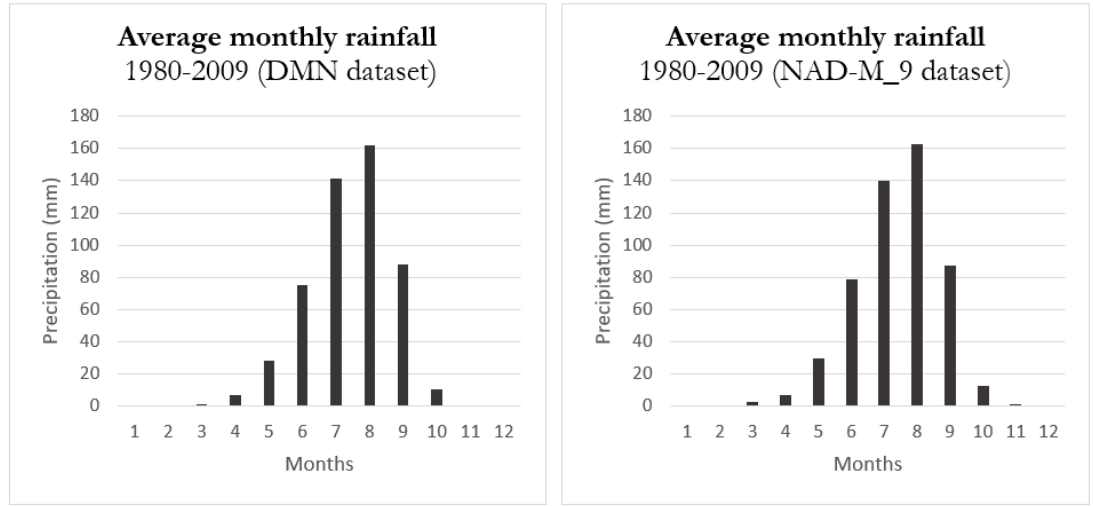
Figure 3. Precipitation standard year. DMN dataset: observed precipitation dataset (1980–2012) measured at Niamey airport station made available by the Direction de la Météorologie Nationale (DMN). NAD dataset (Niamey Airport-derived dataset): simulated precipitation series (1950–2009) for Niamey Airport.